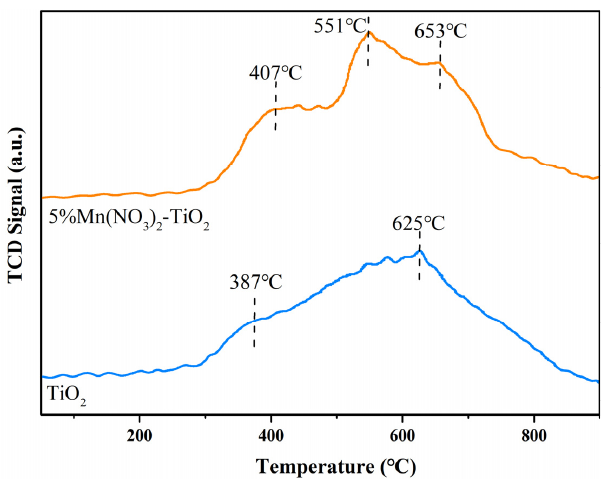
Figure 13. H 2 -TPR profiles.